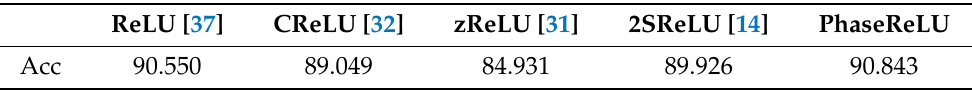
Table 1. The accuracy (%) of PhaseReLU and other existing complex-valued activation functions on Fashion-MNIST from LeNet-3.